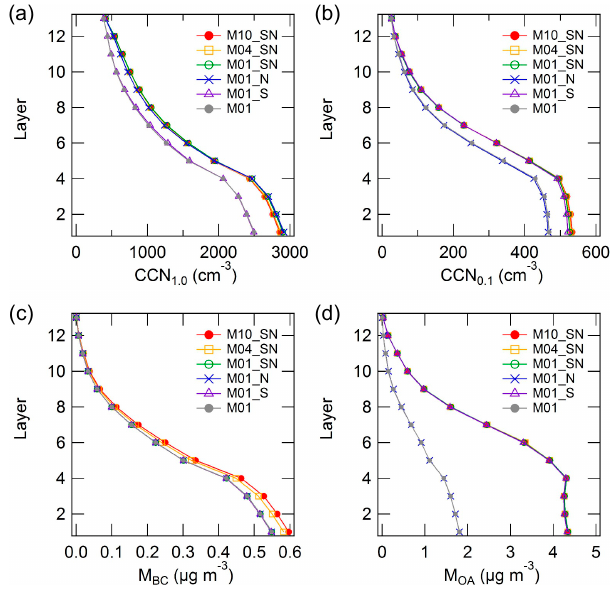
Figure 7. The period- and domain-averaged vertical profiles of (a) CCN 1 . 0 , (b) CCN 0 . 1 , (c) BC mass, and (d) OA mass concen- trations in six